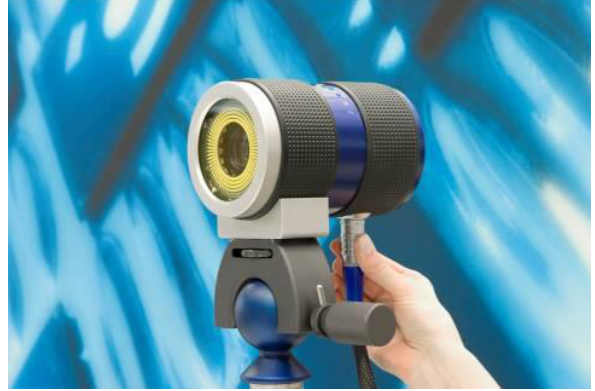
Figure 9: MoveInspect HF camera